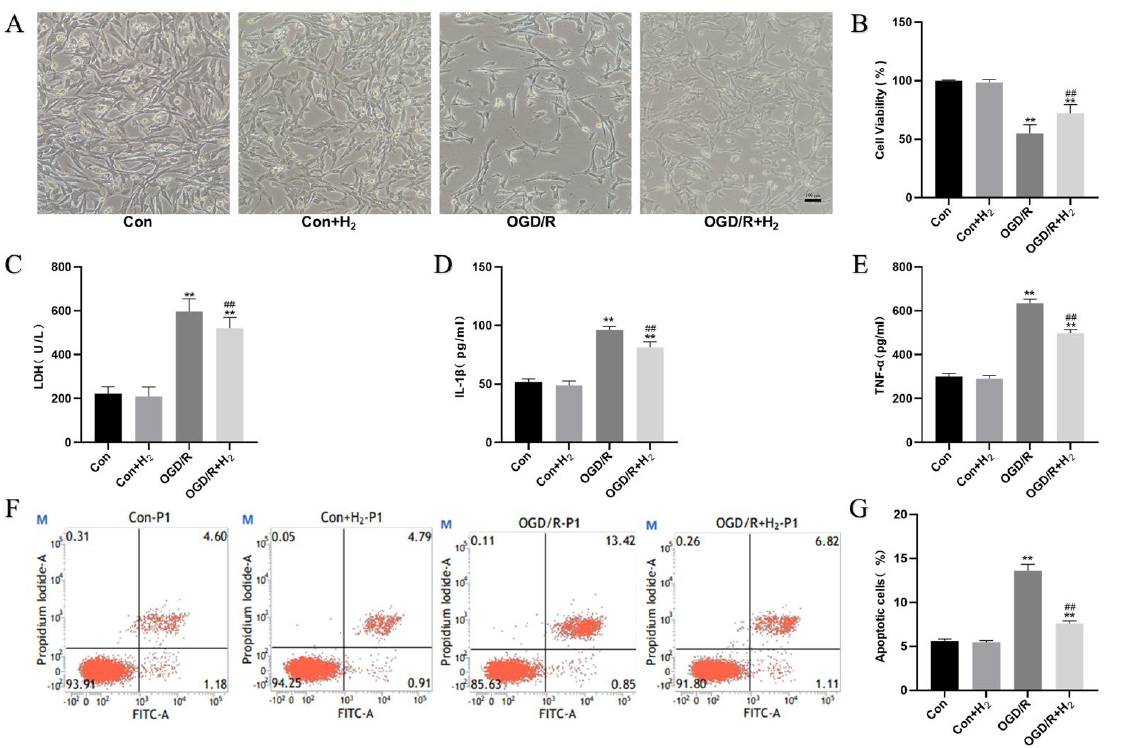
Figure 2. Neuroprotective effects of H 2 against OGD/R injury. ( A ) Representative light microscopy of HT22 cells treated with or without hydrogen post-OGD/R injury. ( B ) The influence of H 2 on neuronal viability of HT22 cells post-OGD/R injury. ( C ) The release of LDH in each group. ( D ) The IL1- β level in the medium. ( E ) The TNF- α level in the medium. ( F ) Images of HT22 cell analysis by flow cytometry as shown by dot plots. ( G ) Flow cytometry was used for the quantitative analysis of the apoptotic rate. The data were displayed as mean ± SD. Three independent runs of the experiments yielded similar results. ** p < 0.01 vs. Con group. ## p < 0.01 vs. OGD/R group.